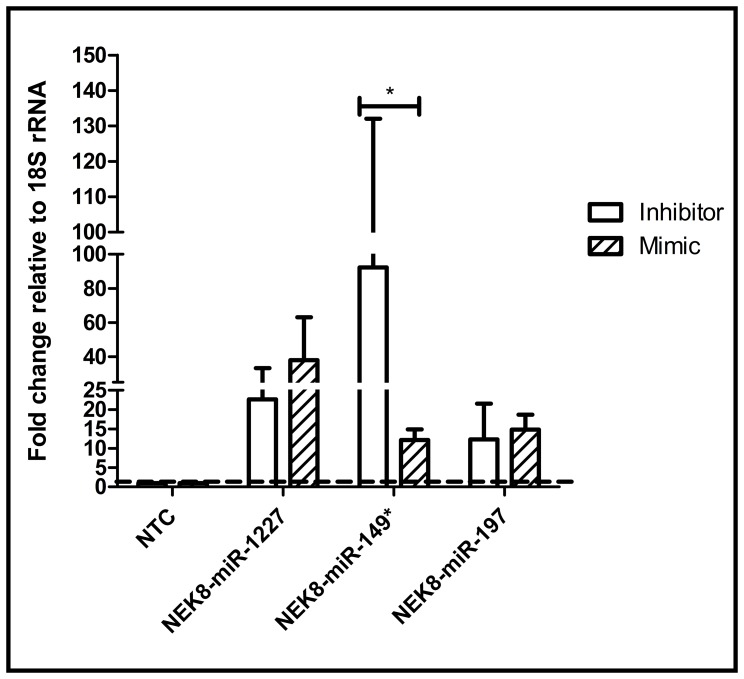
miRNA regulators of NEK8.A549 cells were transfected with 25 nM of miR-1227, -149* and -197 inhibitor/mimic for 48 hrs followed by RNA extraction and RT-qPCR with NEK8 specific primers. Expression data was normalized to 18S rRNA expression and shown as mean±SEM of independent experiments. *p<0.05 compared to control.